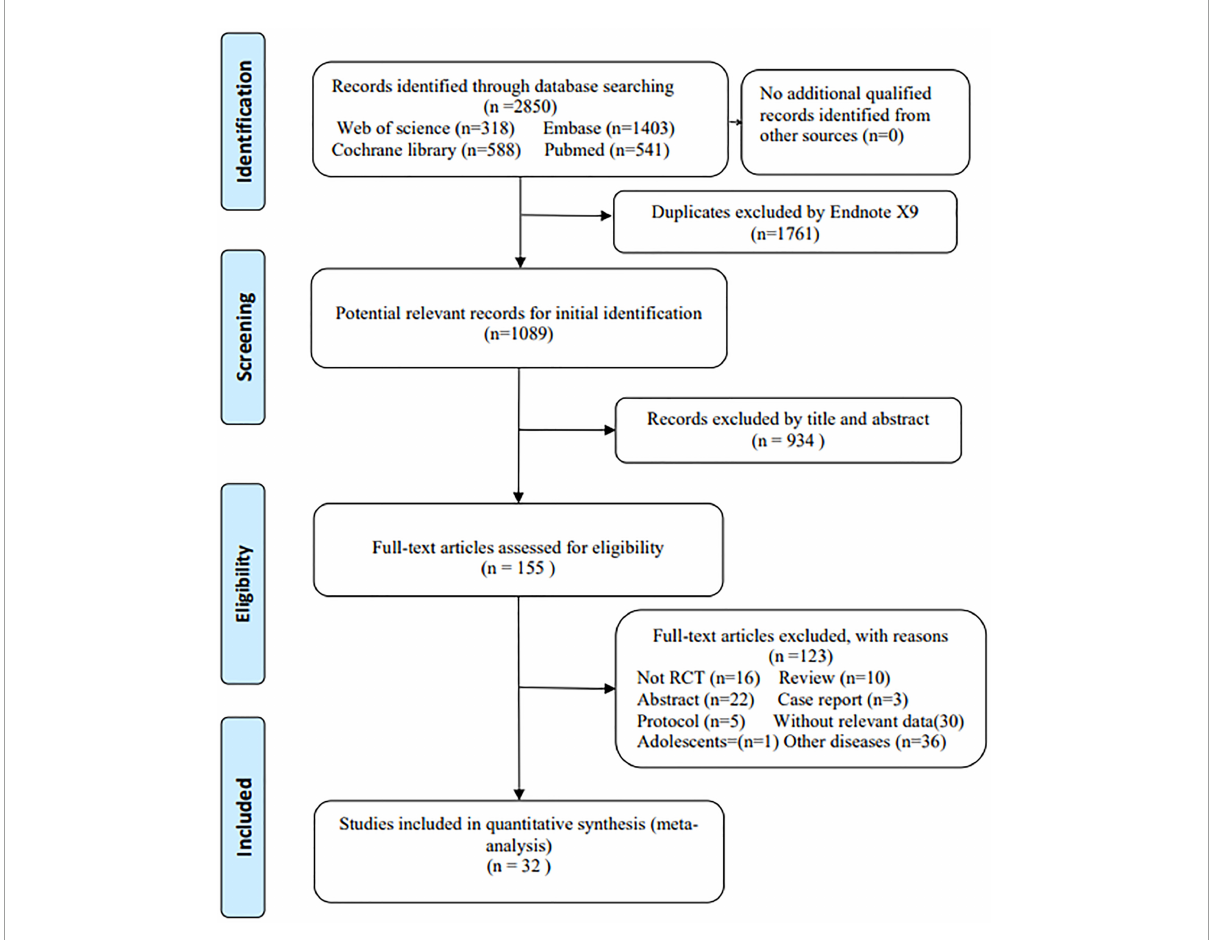
FIGURE1 The flowchart of the study selection